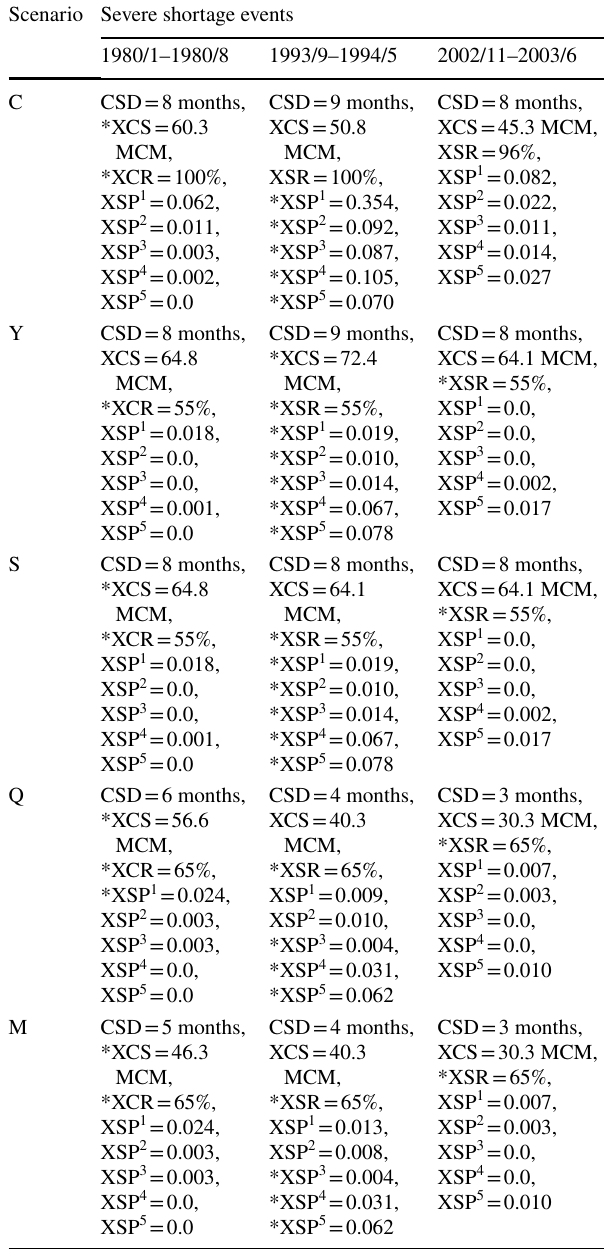
Table 3 Comparison of performance of severe drought events for